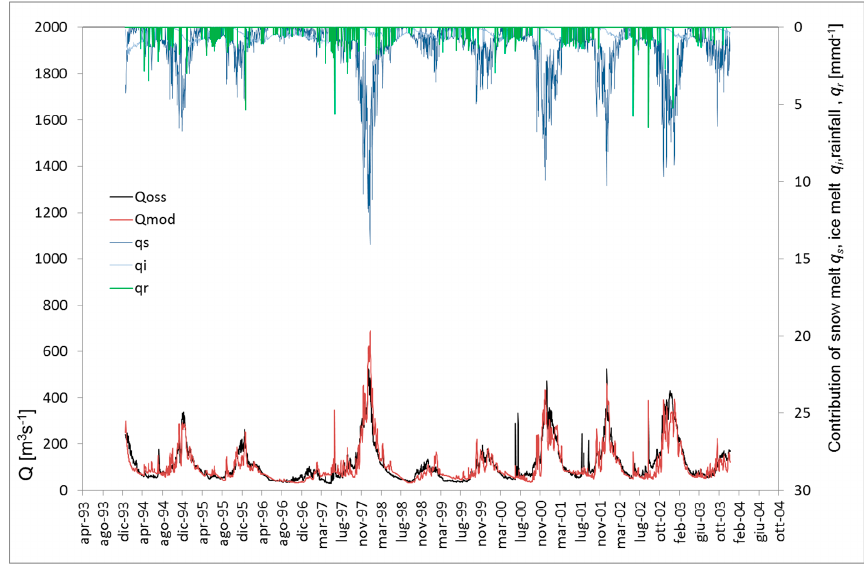
Figure 2. Rio Maipo at El Manzano. Model calibration (1994–2013). Flow contribution (mmd − 1 ), snow melt q s , ice melt q i , rainfall q r .